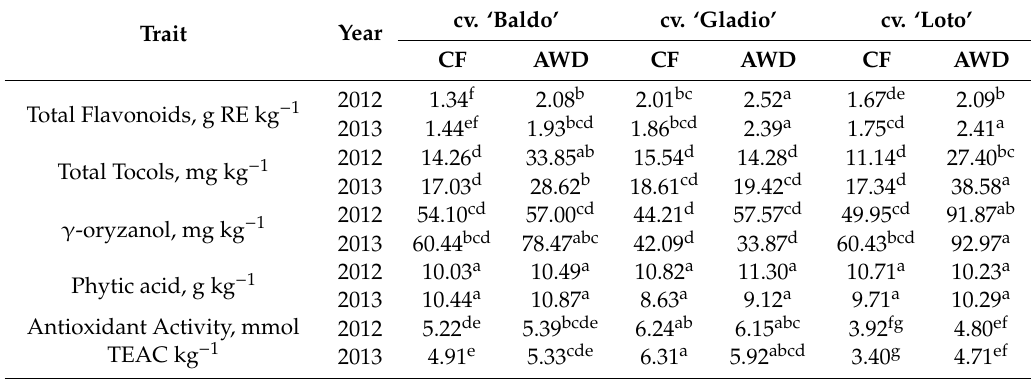
Table 3. Total concentrations of health-promoting compounds and antioxidant activity in brown grains of three rice cultivars grown under continuous flooding (CF) or alternate wetting and drying (AWD). cv. ‘Baldo’ cv. ‘Gladio’ cv. ‘Loto’ Trait Year CF AWD